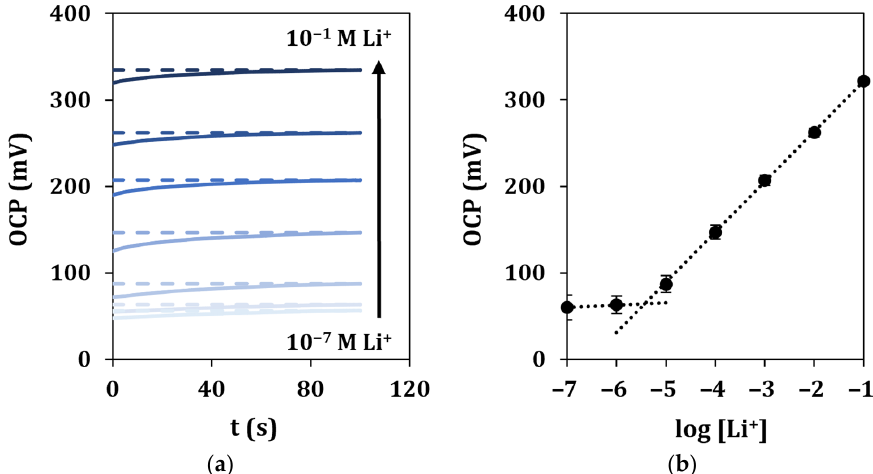
Figure 6. In ‐ drop lithium detection in standard solutions. ( a ) Recorded OCP signals vs. time for a total duration of 100 s, and ( b ) corresponding calibration curve. Each measurement was repeated at least 5 times using the same sensor.